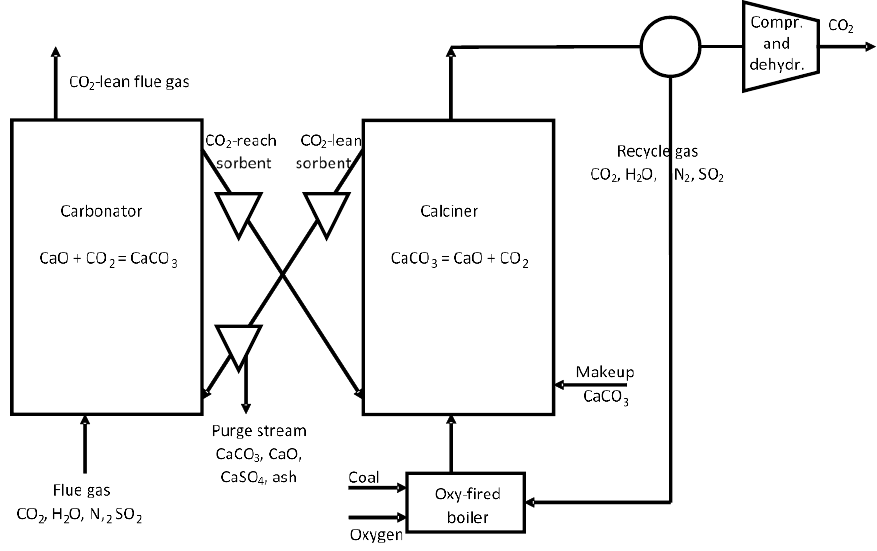
Figure 1. Diagram of the calcium looping (CaL) process for CO 2 capture, according to [13]. The efficiency of CO 2 capture (carbonation) by the sorbent and its regeneration (calci- nation) depends on the reaction kinetics, the sorbent grain size, its specific surface area, and the pore space characteristics. The cyclicity of the CaL process is accompanied